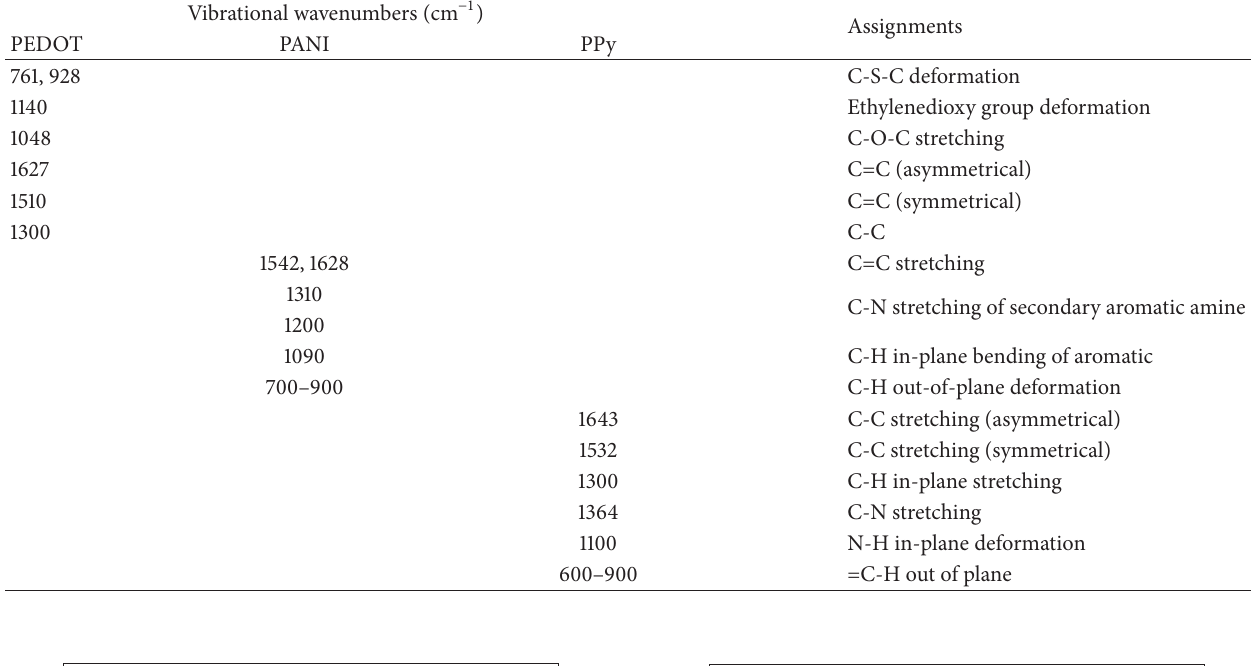
Table 1: FTIR assignments for the main vibrations of the PEDOT, PANI, and PPy films.